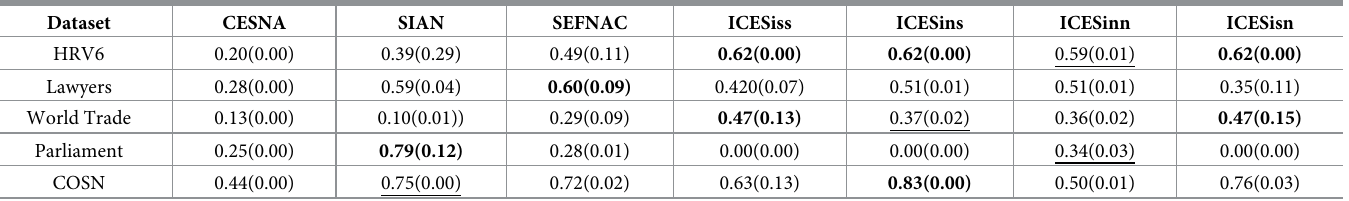
Table 9. The comparison of CESNA, SIAN, SEFNAC and ICESi methods at Real-world data sets; average values of ARI are presented over 10 random initialization.